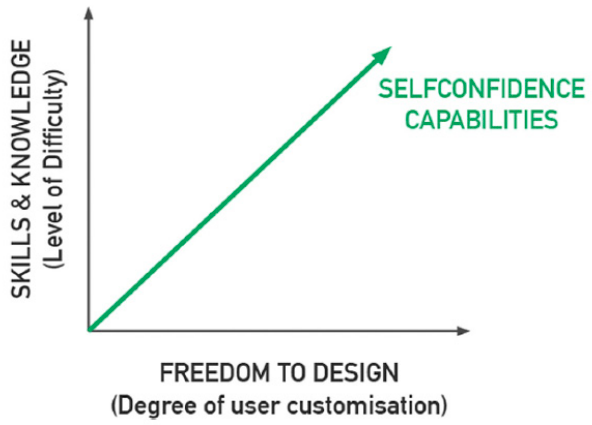
Figure 2. Increased skill-level results in greater self-confidence and capabilities.